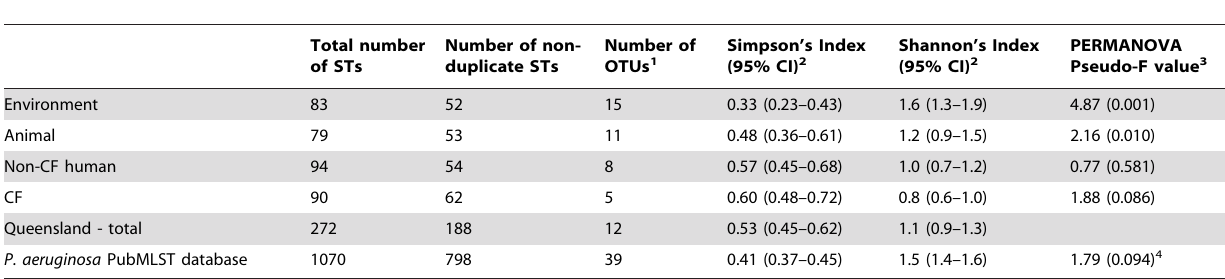
Table 3. Genetic diversity amongst Pseudomonas aeruginosa genotypes collected from each ecological setting, all Queensland sources and the Pseudomonas aeruginosa PubMLST